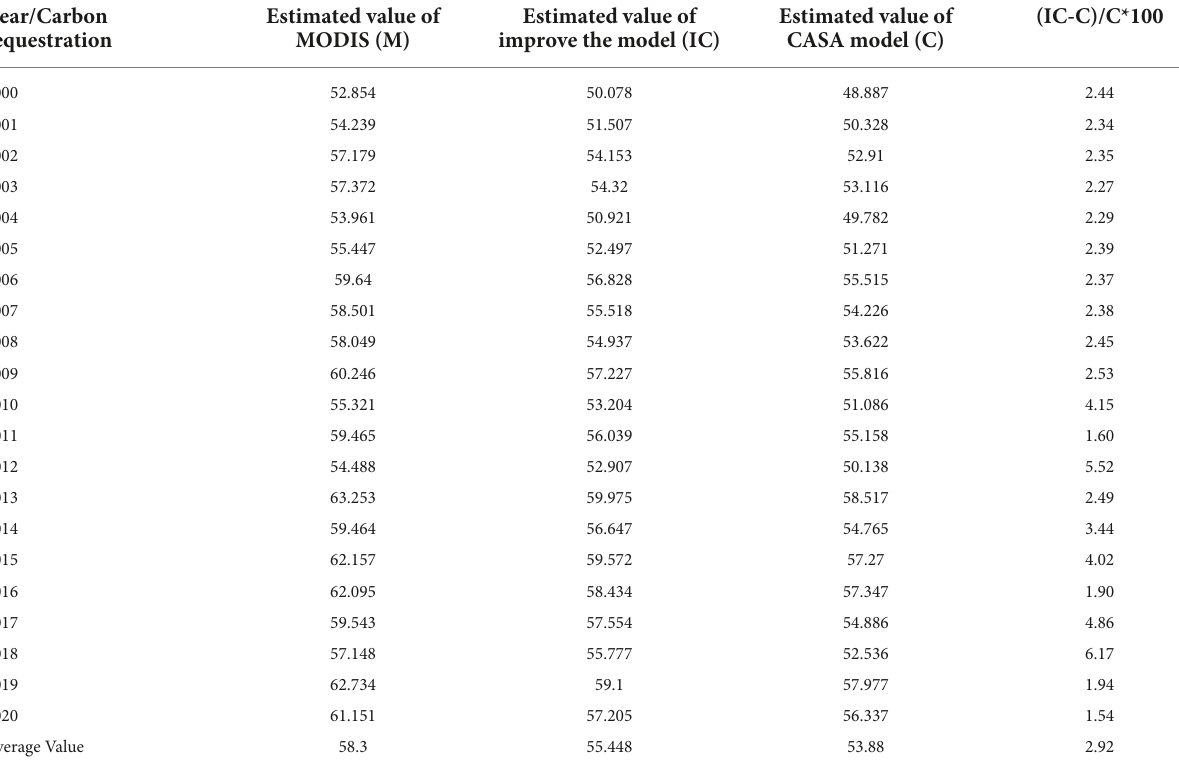
TABLE 4 Estimation of vegetation carbon sequestration in the study area from 2010 to 2020 (unit: 10,000 tons). Year/Carbon